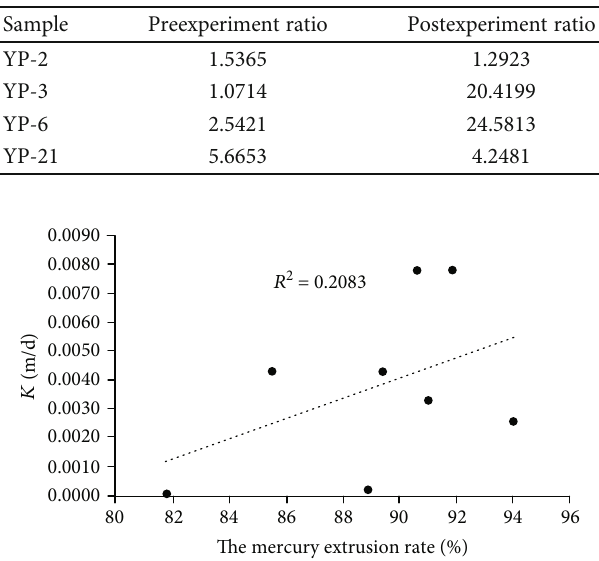
Figure 10: Correlation curves between the hydraulic conductivity and the mercury extrusion rate.